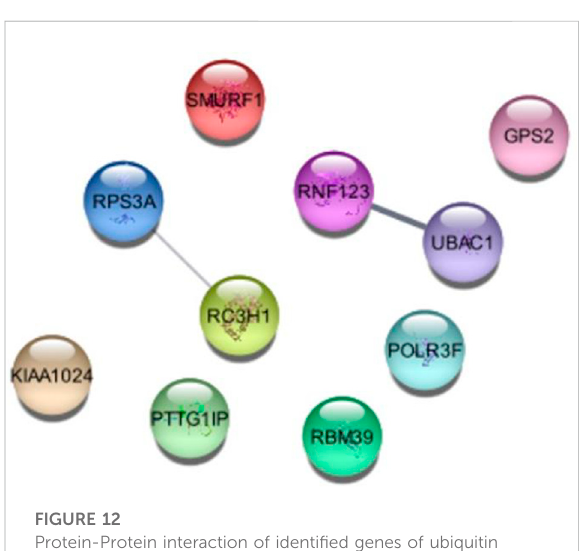
FIGURE 12 Protein-Protein interaction of identi fi ed genes of ubiquitin